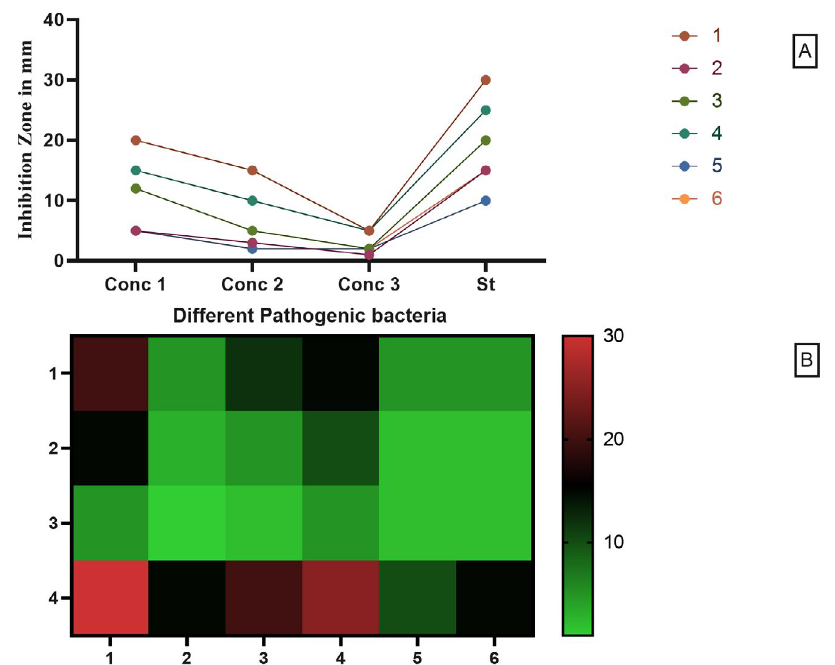
Fig. 8. The antimicrobial activity of Free Cell Culture compared to six different pathogenic